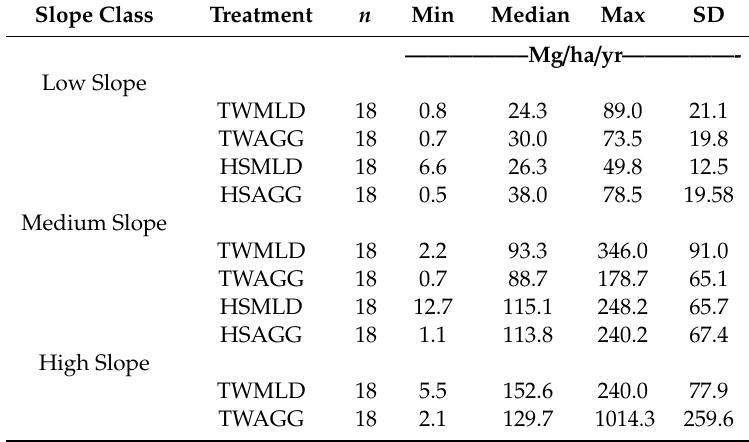
Table 5. Descriptive statistics for the weighted average erosion rates for each treatment within each slope